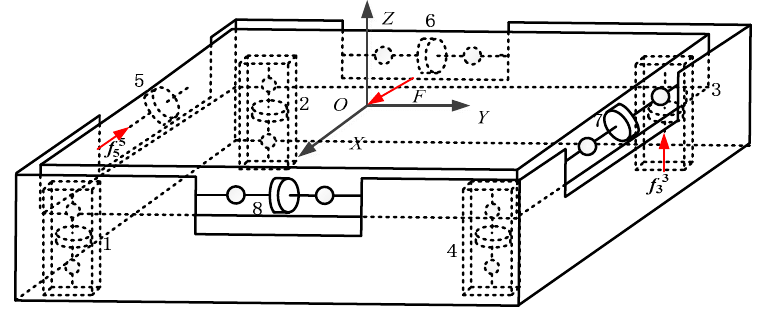
Figure 4. Force diagram of the basic system of the proposed sensor.